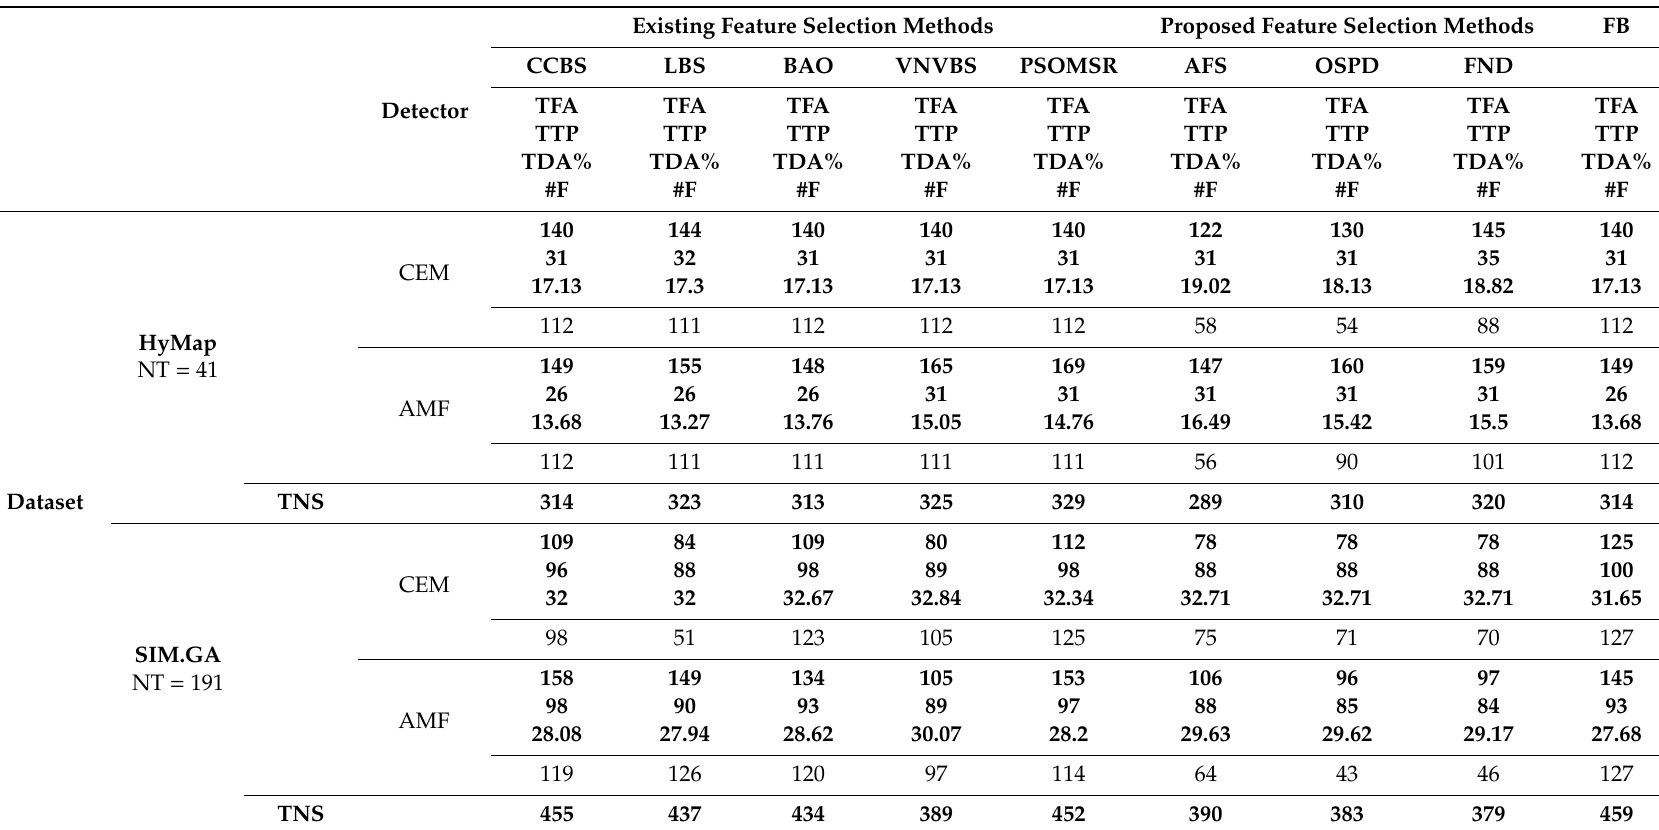
Table 3. Total false alarms (TFA) and the corresponding total true positives (TTP) achieved by the feature selection (FS) methods based on the maximum